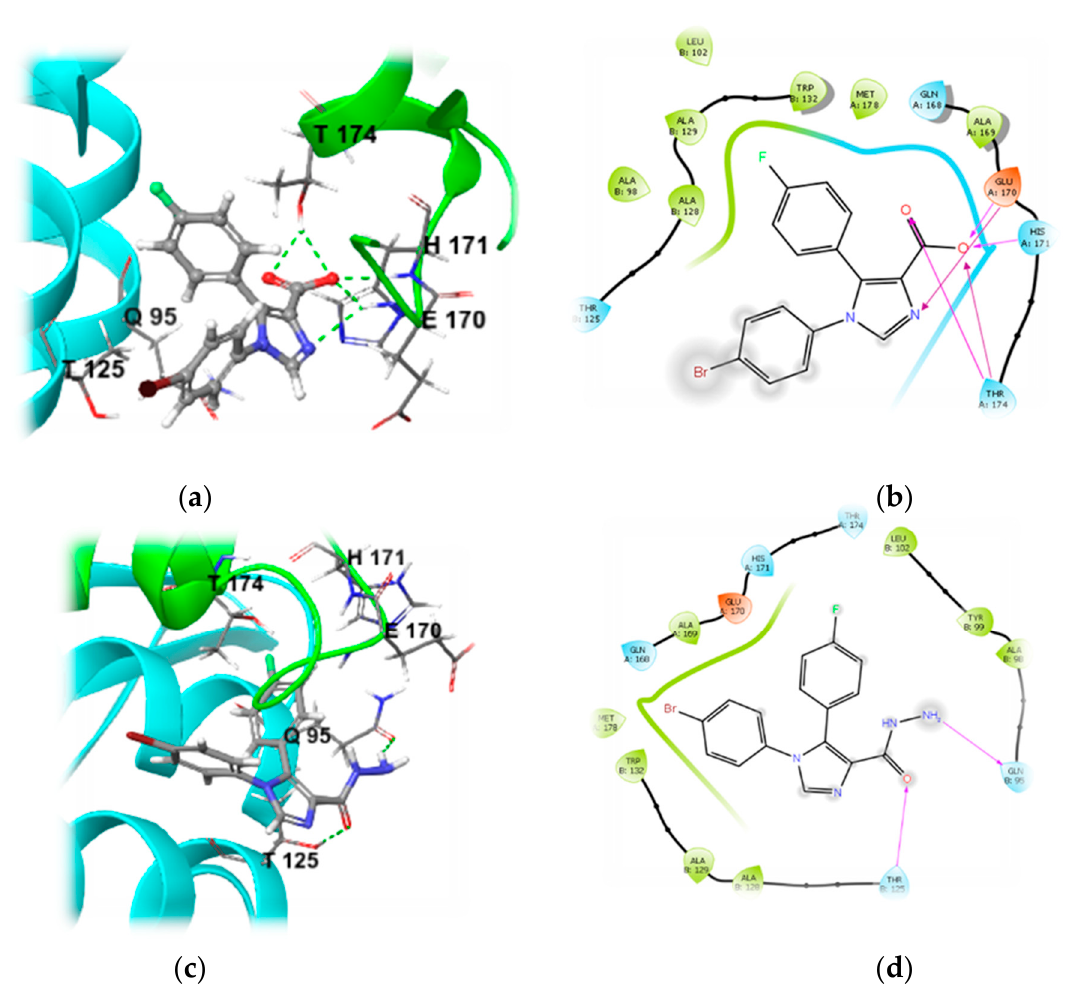
Figure 3. Docking studies: ( a ) 3D model of structure 10a docked at the LEDGF/p75 binding site in HIV-1 integrase (PDB code: 4NYF, chain A: green and chain B: light blue); ( b ) 2D view of structure 10a at the LEDGF/p75 binding site in HIV-1 integrase; ( c ) the 3D mode of compound 11a binding at the LEDGF/p75 binding site in HIV-1 integrase; ( d ) 2D image of structure 11a at the LEDGF/p75 binding site in HIV-1 integrase. Hydrogen bonds are represented by the green dotted lines in 3D structures ( a , c ) and as purple arrows in 2D views ( b , d ).